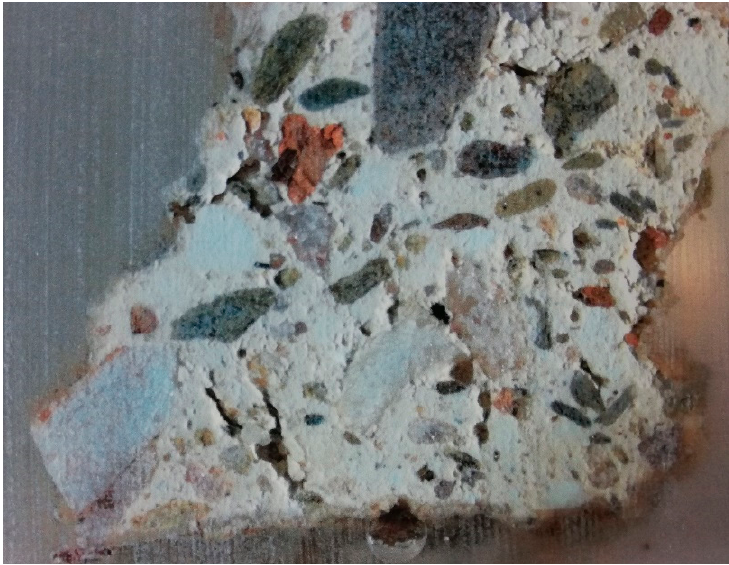
Figure 31. Diagnosis of the mortars used in the paintings of Santa Maria de Terrassa. © Museu de Terrassa (with kind permission). Terrassa (with kind